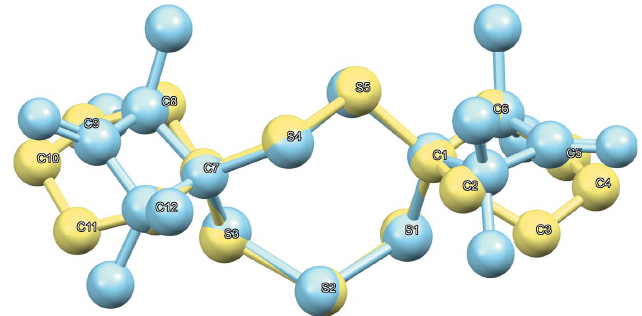
Figure 2 An overlay ( Mercury; Macrae et al. , 2006) of 7,8,15,16,17-pentathiadi- spiro[5.2.5 9 .3 6 ]heptadecane (yellow) and the related structure from the CSD (blue, CSD refcode: MOSYOI; Mloston et al. , 2002). Only the atom labels for the title compound are shown; H atoms are omitted for clarity.